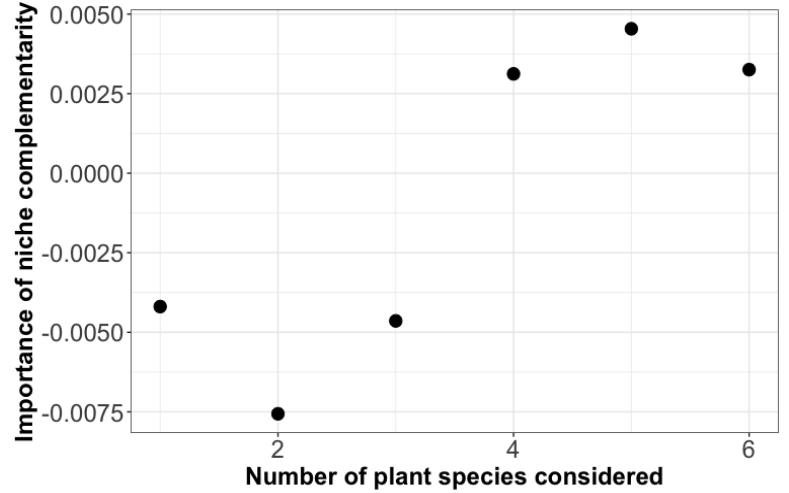
Figure 3. Results of simulation evaluating the importance of niche complementarity in determining differences in equity in reproductive across communities harboring from one to six species. Points represent average values across 1,000 simulated